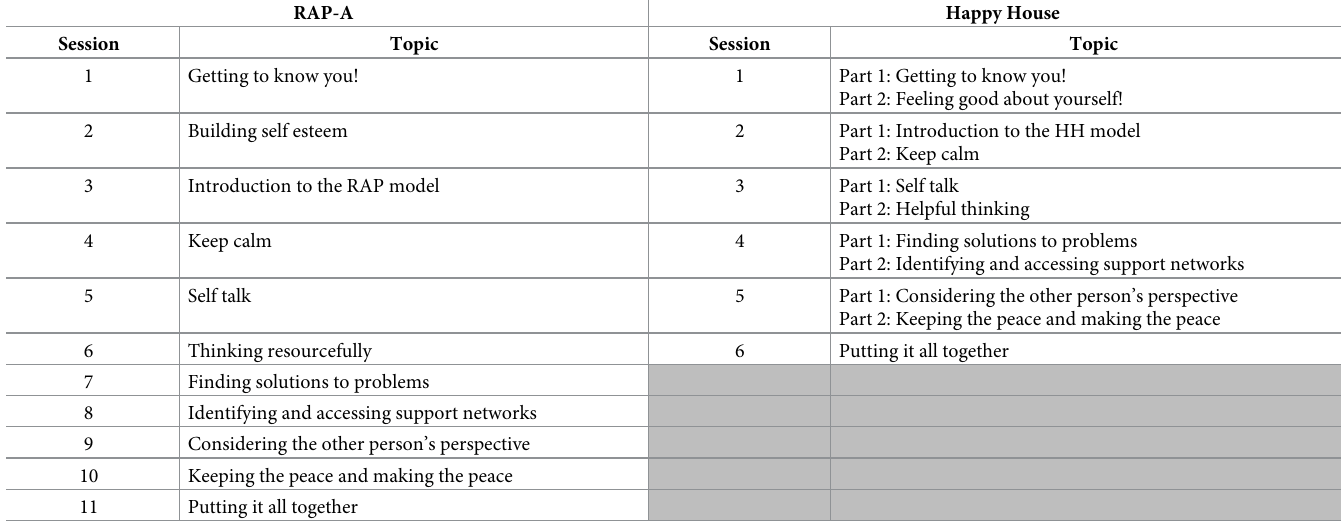
Table 2. Structure of RAP-A and the Happy House program.